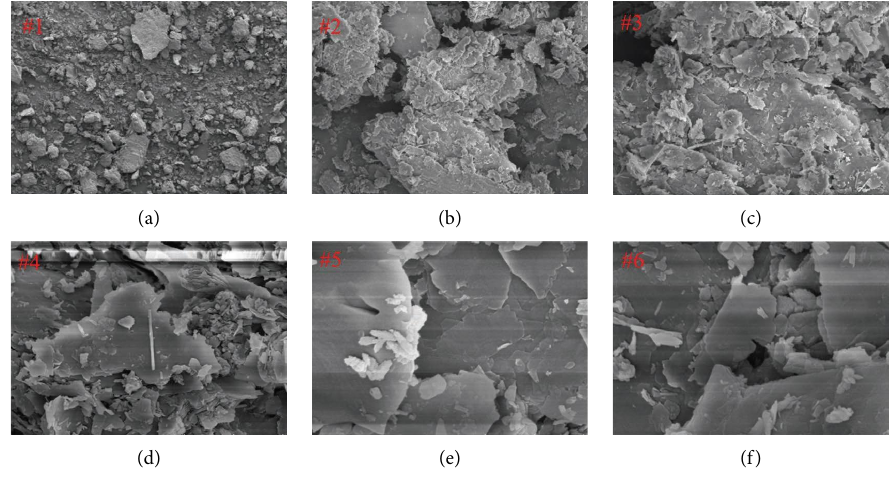
Figure 8: SEM images of material